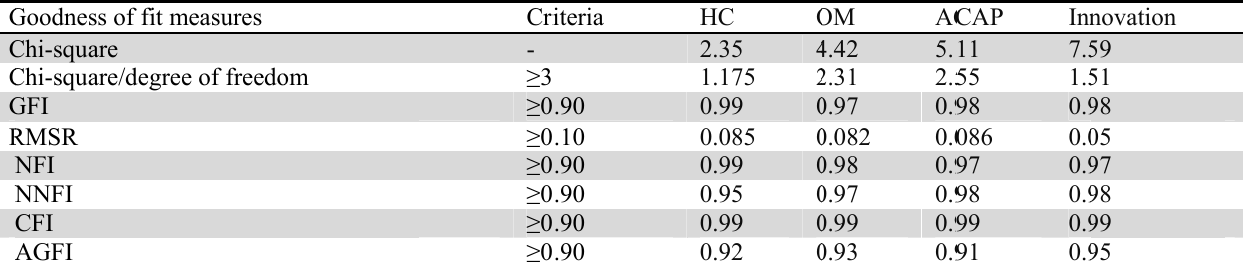
fit measures gree of